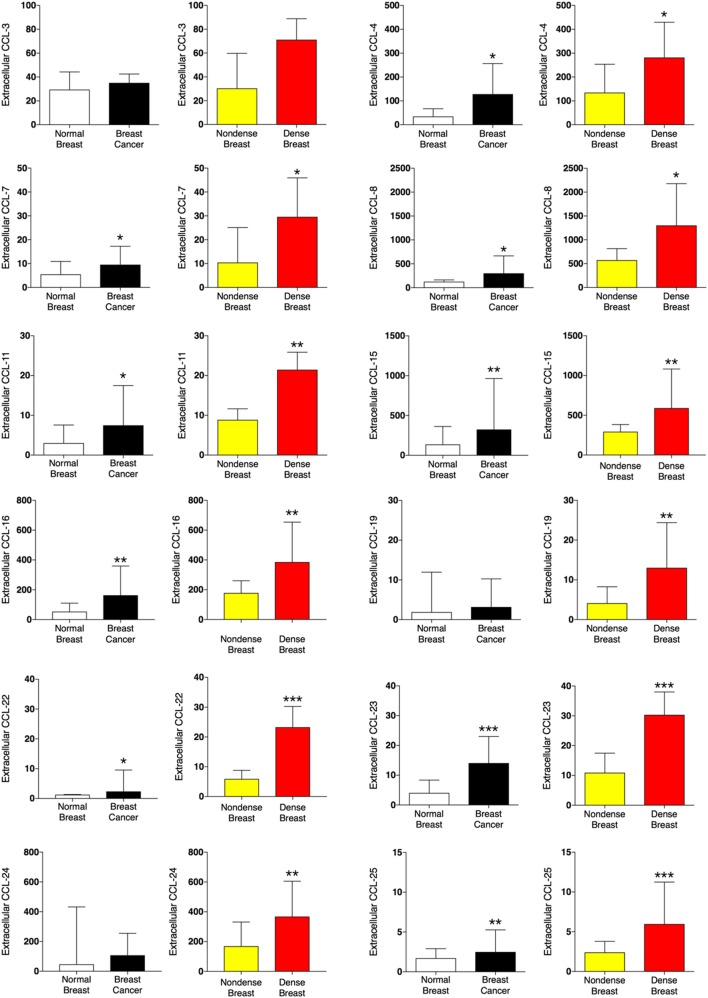
Extracellular levels of CCLs in vivo in breast cancers and healthy normal breast tissue with different densities. 51 women were investigated using microdialysis; 12 breast cancer patients underwent microdialysis before surgery. One catheter was inserted into the breast cancer (black bars) and another into adjacent normal breast tissue (white bars). 39 postmenopausal healthy volunteer women, attending the regular mammography-screening program and were categorized as either having dense or non-dense breasts underwent microdialysis of their left breast. Women with dense breasts (n = 20) are depicted in red and women categorized as non-dense (n = 19) are depicted in yellow. Data represent protein abundance in linear values (2NPX as described in the Section “Materials and Methods”). Graphed data are presented as median with 95% CI (*P < 0.05, **P < 0.01, ***P < 0.001).